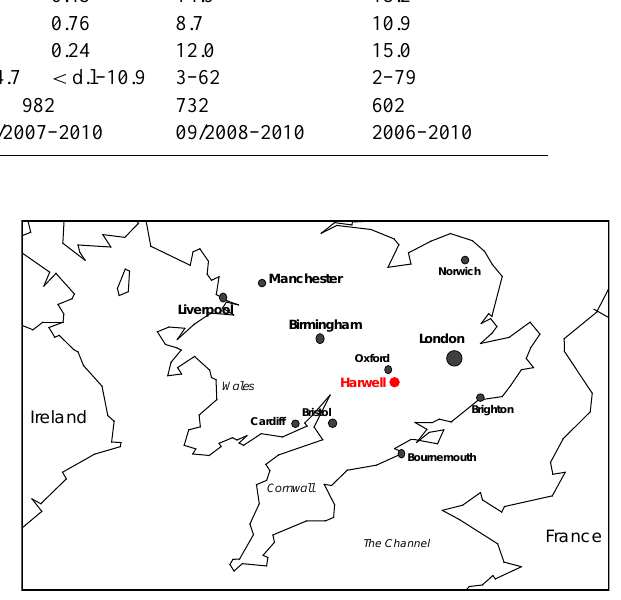
Fig. 1. Map of England with the locations of Harwell, Birmingham and London (stereographic projection true at 60 ◦